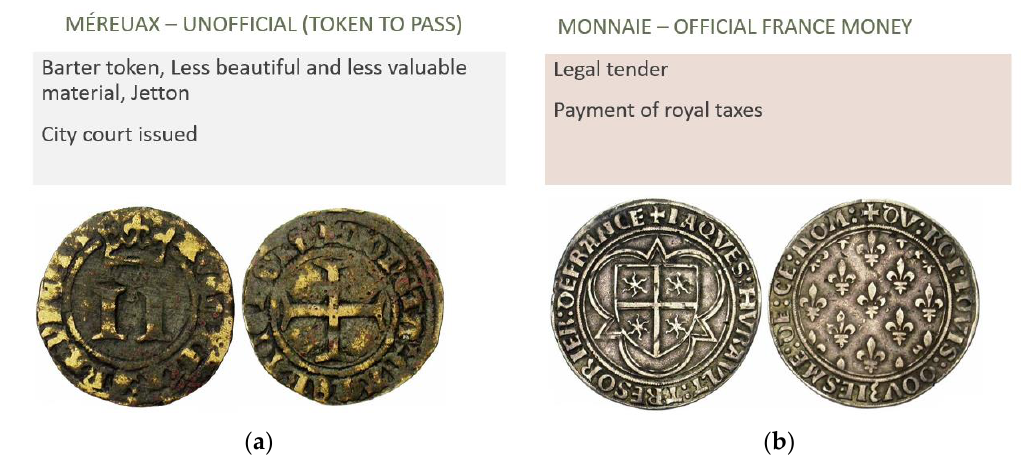
Figure 1. Difference between token and currency in France; ( a ) two-denier mereau coined by the cathedral chapter; and ( b ) a Jacques Hurault de Cheverny coin, treasurer of France. (Source: Méreaux